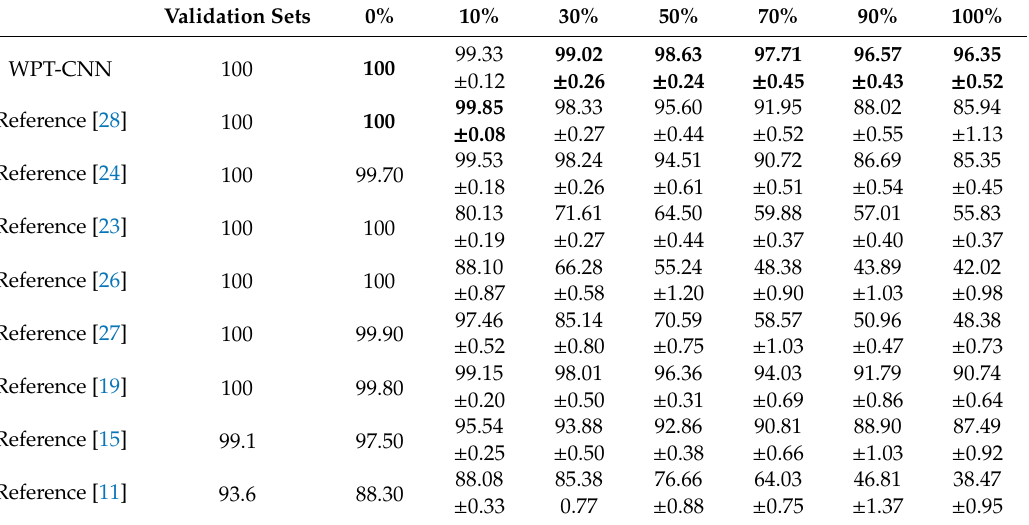
Table 12. Resistance of various algorithms to various percentages of added white Gaussian noise.